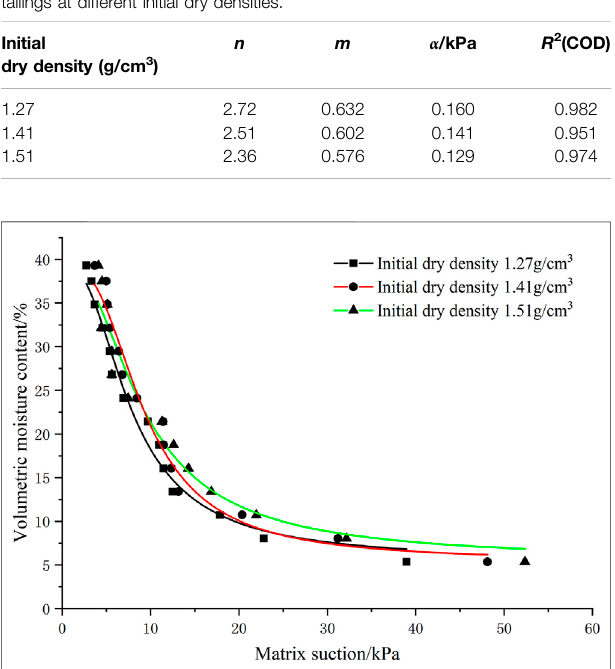
porosity. The fi tting parameter α value decreased with decreasing temperature, are minimum in winter and maximum in summer, indicating that a decrease in temperature can improve the water- holding capacity of fi ne-grained tailings.